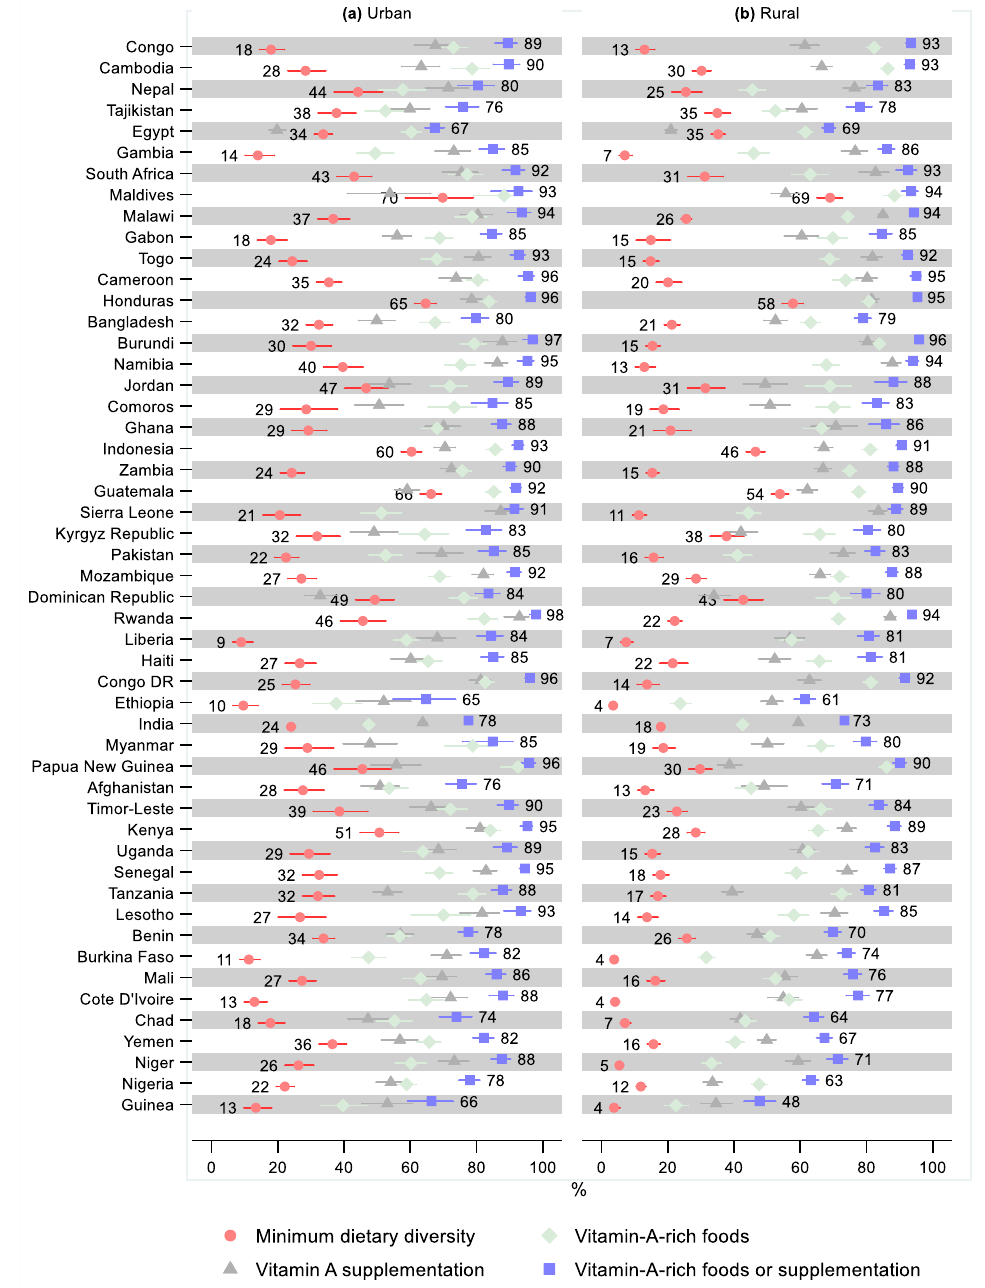
Figure 8. Percentage of children 6–23 months old that received minimum dietary diversity, vitamin- A-rich foods, vitamin A supplementation, and either vitamin-A-rich foods or vitamin A supplemen- tation by urban–rural residency and country. Notes: 95% confidence intervals are shown. Countries are ordered from largest to smallest relative urban–rural residency difference in percentage of chil- dren that received either vitamin-A-rich foods or supplementation. Some confidence intervals may be narrower than the symbol for the estimate and therefore not visible. See Tables S13–S16 in the Supplement for the tabulated estimates and confidence intervals. See Figures S21–S24 in the Supplement for the plotted relative